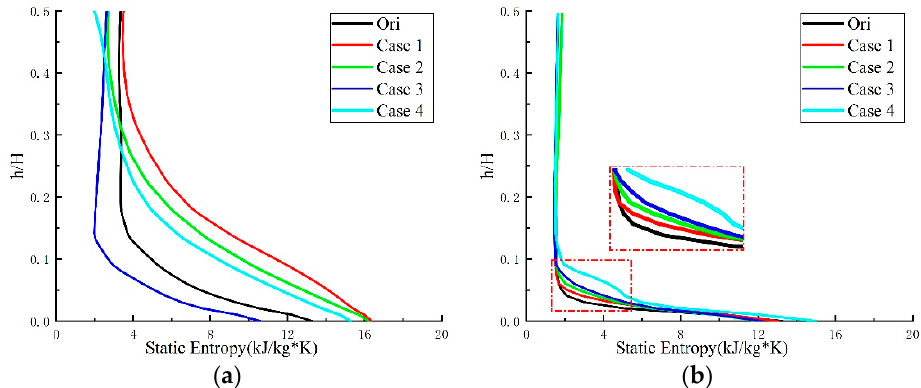
Figure 13. Radial distribution of static entropy for ( a ) OP2 and ( b ) OP1.